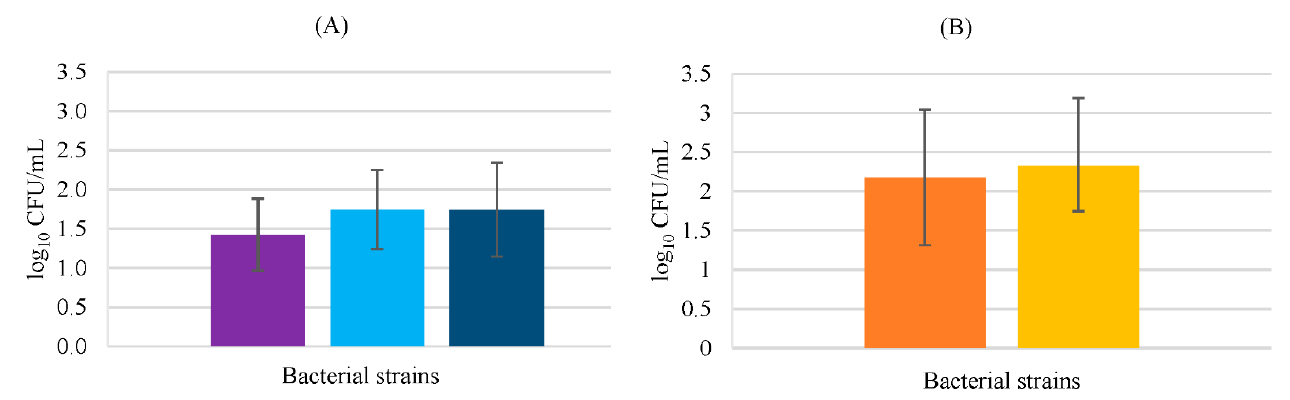
Figure 3. HaCaT cell invasion by P . aeruginosa in the presence of probiotic bacteria. P . aeruginosa counts in BHI medium ( A ) Lacticaseibacillus rhamnosus ( ■ ), Lactobacillus delbrueckii subsp. bulgaricus ( ■ ), and Propioniferax innocua ( ■ ); counts in MRS medium ( B ) Lacticaseibacillus rhamnosus ( ■ ), Lac- tobacillus delbrueckii subsp bulgaricus ( ■ ). Error bars are ± standard deviation. Pseudomonas aeruginosa invasion in the presence of L . rhamnosus resulted in a lower number of cells internalized compared with the remaining probiotic bacteria; however, this difference was not statistically significant ( p > 0.05). The antimicrobial activity of this probiotic against P . aeruginosa has been studied previously, revealing positive results in a study where the pathogen was isolated from burn and wound infections, and analyzed with the plate diffusion method